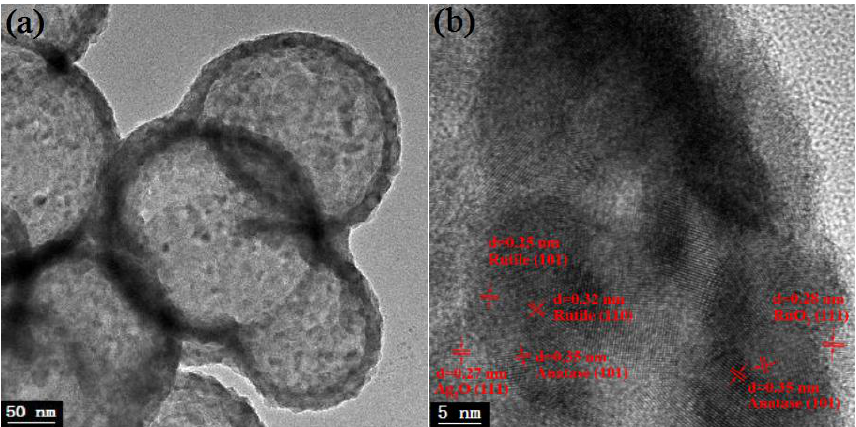
Figure 3. ( a ) Transmission electron microscopy (TEM) and ( b ) High resolution transmission electron microscopy (HRTEM) images of Ag-I-RuO 2 -O-THS.